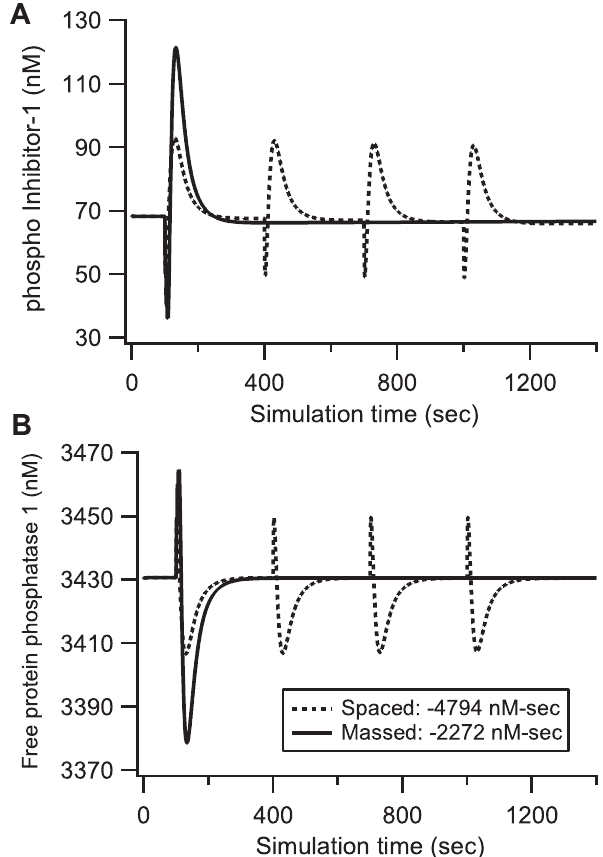
Figure 6. The increase in PKA activity due to spaced stimulation propagates to downstream targets inhibitor-1 and protein phosphatase 1. (A) The amount of phosphorylated inhibitor-1 is , 50% higher for spaced than massed stimulation. The initial decrease in phosphorylated inhibitor-1 (below baseline) is due to activation of protein phosphatase 2B. (B) The sharp peaks of protein phosphatase 1 during stimulation are caused by the initial decrease of phosphorylated inhibitor-1. These transient increases are followed by longer periods of decrease in free protein phosphatase 1 below basal level, caused by an increase of phosphorylated inhibitor-1. This simulation shows the concentration of protein phosphatase 1 is reduced , 50% more by the spaced stimulation protocol than the massed protocol (in the legend a negative value of area under the curve denotes a decrease in